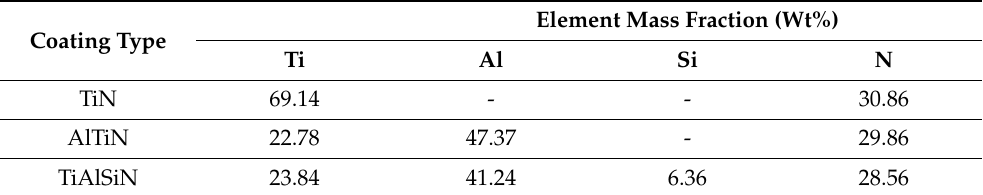
Figure 1. Coated carbide drill. ( a ) Uncoated. ( b ) TiN. ( c ) AlTiN. ( d ) TiAlSiN. Table 5. Chemical composition of YG10 carbide drill.